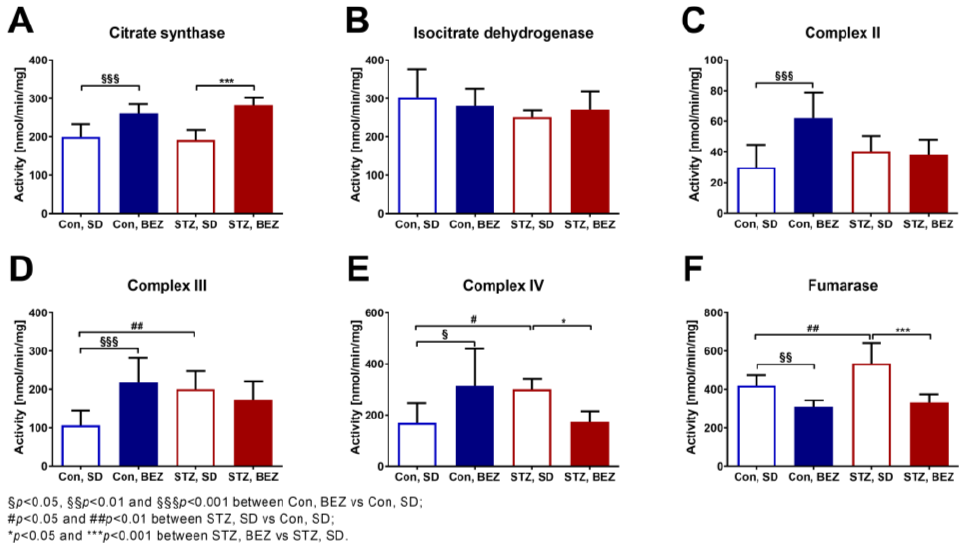
Figure 5. Mitochondrial enzyme activities were measured in liver samples of BEZ-treated STZ mice ( A – F ). Columns represent averages ± standard deviation; n = 6-8. ANOVA with post hoc Holm – Sidák multiple comparison test was applied.